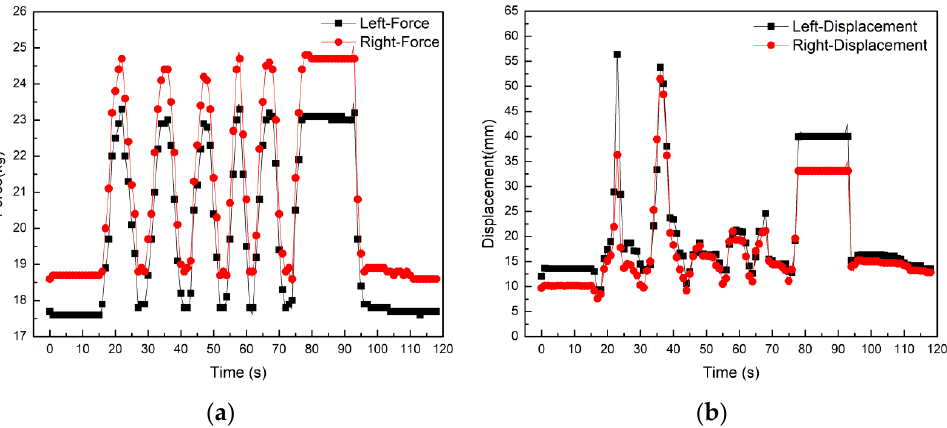
Figure 22. ( a ) Force curve of in situ squat standing; ( b ) displacement curve of in situ squat stand- ing.